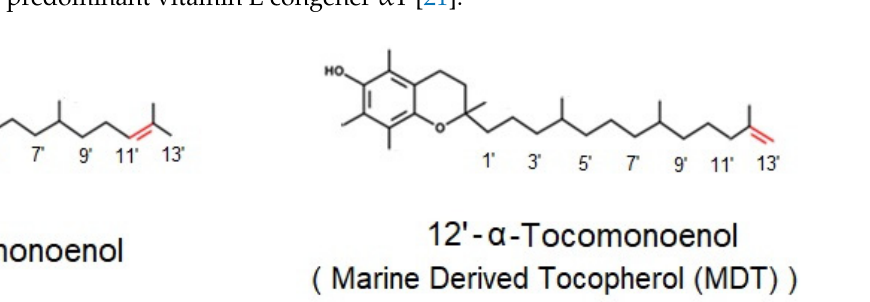
Figure 1. Chemical structure of 11 ′ - α -tocomonoenol (11 ′ - α T1) and 12 ′ - α -tocomonoenol (also known as marine-derived tocopherol (MDT); 12 ′ - α T1) [18,19]. 12 ′ - α T1 was originally found in marine products, such as fish [18,22,23], fish products [24], and phytoplankton [18,23], while 11 ′ - α T1 has been reported in a range of vegetable